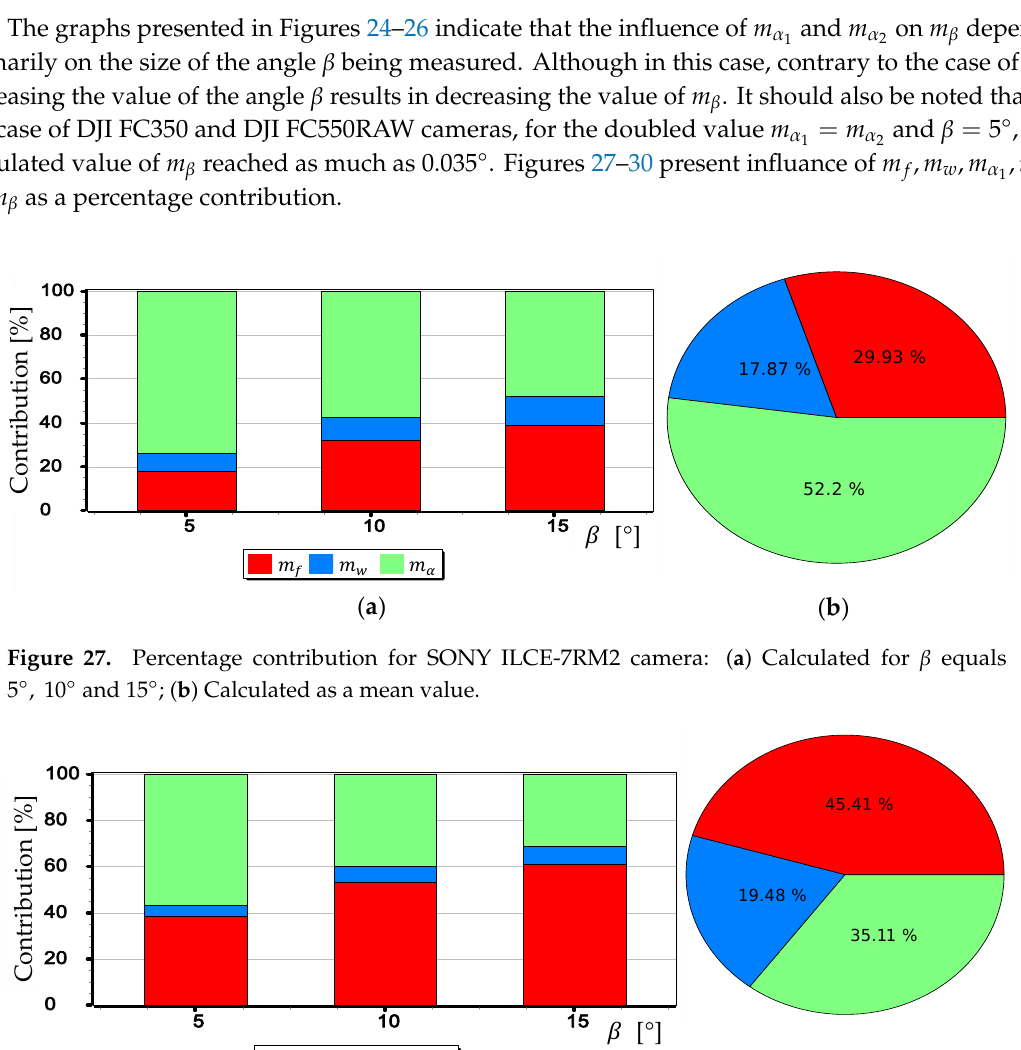
Figure 26. Mean error of measurement 𝑚 𝛽 as a function of 𝑚 𝛼 two components of the Formula (3) were used in the calculations).